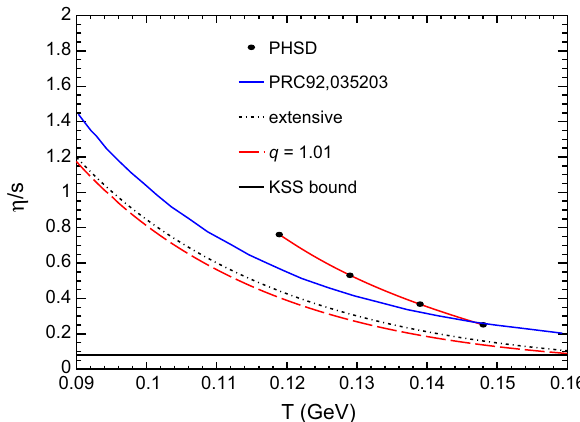
Fig. 4 Comparisonof η/ sresultsestimatedinvarioustheoreticalmod- els